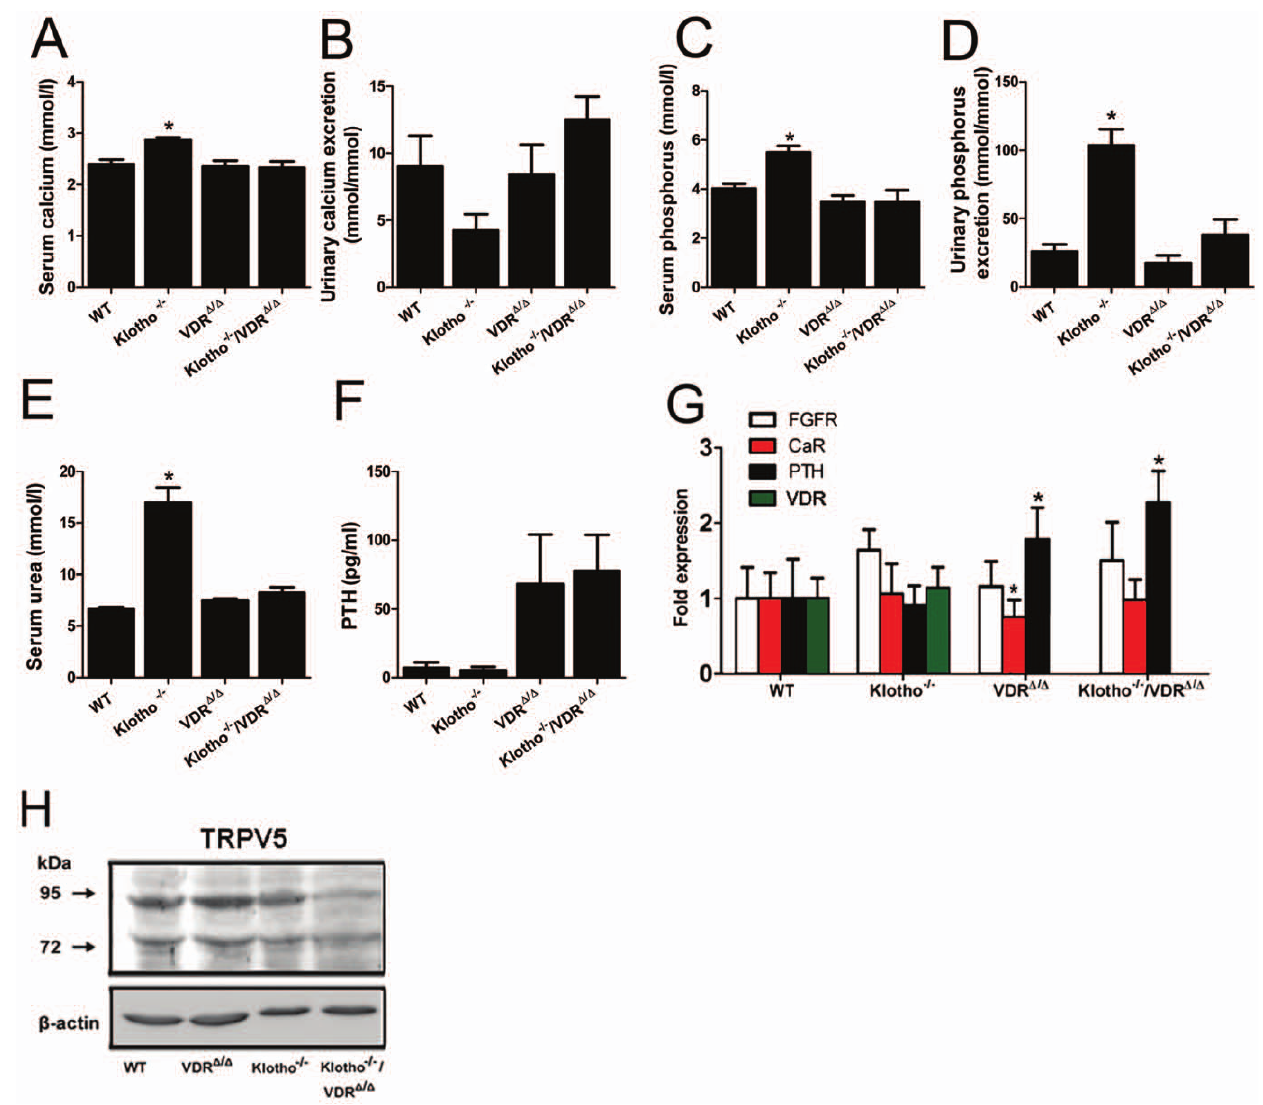
Figure 3. Defects in mineral homeostasis observed in Klotho 2 / 2 mice are normalized in Klotho 2 / 2 /VDR D / D double mutant mice. ( A–D ) Analysis of mineral homeostasis in serum and urine shows hypercalcemia, hyperphosphatemia, and hyperphosphaturia in Kl 2 / 2 mice compared with WT controls, whereas compound mutants are normocalcemic and normophosphatemic. ( E ) Kl 2 / 2 mice display about 2- to 3-fold higher serum urea values than WT mice. ( F ) Serum intact parathyroid hormone (PTH) tends to be higher in VDR and compound mutants, relative to WT mice (n=8–10 each). ( G ) mRNA abundance assessed in isolated parathyroid glands by qRT-PCR reveals higher PTH mRNA abundance in VDR and compound mutants relative to WT mice. Relative expression of Fgf receptor 1c (FGFR) and PTH is not different between VDR D / D and compound mutants, but also not different between WT and Kl 2 / 2 mice. Calcium-sensing receptor (CaR) mRNA expression was lower in VDR D / D compared with WT mice. Using primers located in the deleted region of the VDR in gene-targeted VDR D / D mice, relative VDR mRNA expression was not different between WT and Kl 2 / 2 mice, and undetectable in VDR D / D and compound mutants. ( H ) Representative Western blotting image of core (75 kD) and complex (95 kD) glycosylated TRPV5 protein expression in renal cortical total membrane fractions of 4-week-old WT, VDR D / D , Kl 2 / 2 and Kl 2 / 2 / VDR D / D mice. Membrane abundance of fully glycosylated TRPV5 is lower in Kl 2 / 2 and especially in Kl 2 / 2 /VDR D / D mice, relative to WT and VDR D / D mice. All animals were fed the rescue diet. Each data point is the mean 6 SEM of 4–10 animals per genotype. * denotes P , 0.05 vs. WT mice, 1-way ANOVA followed by Student- Newman-Keuls test.